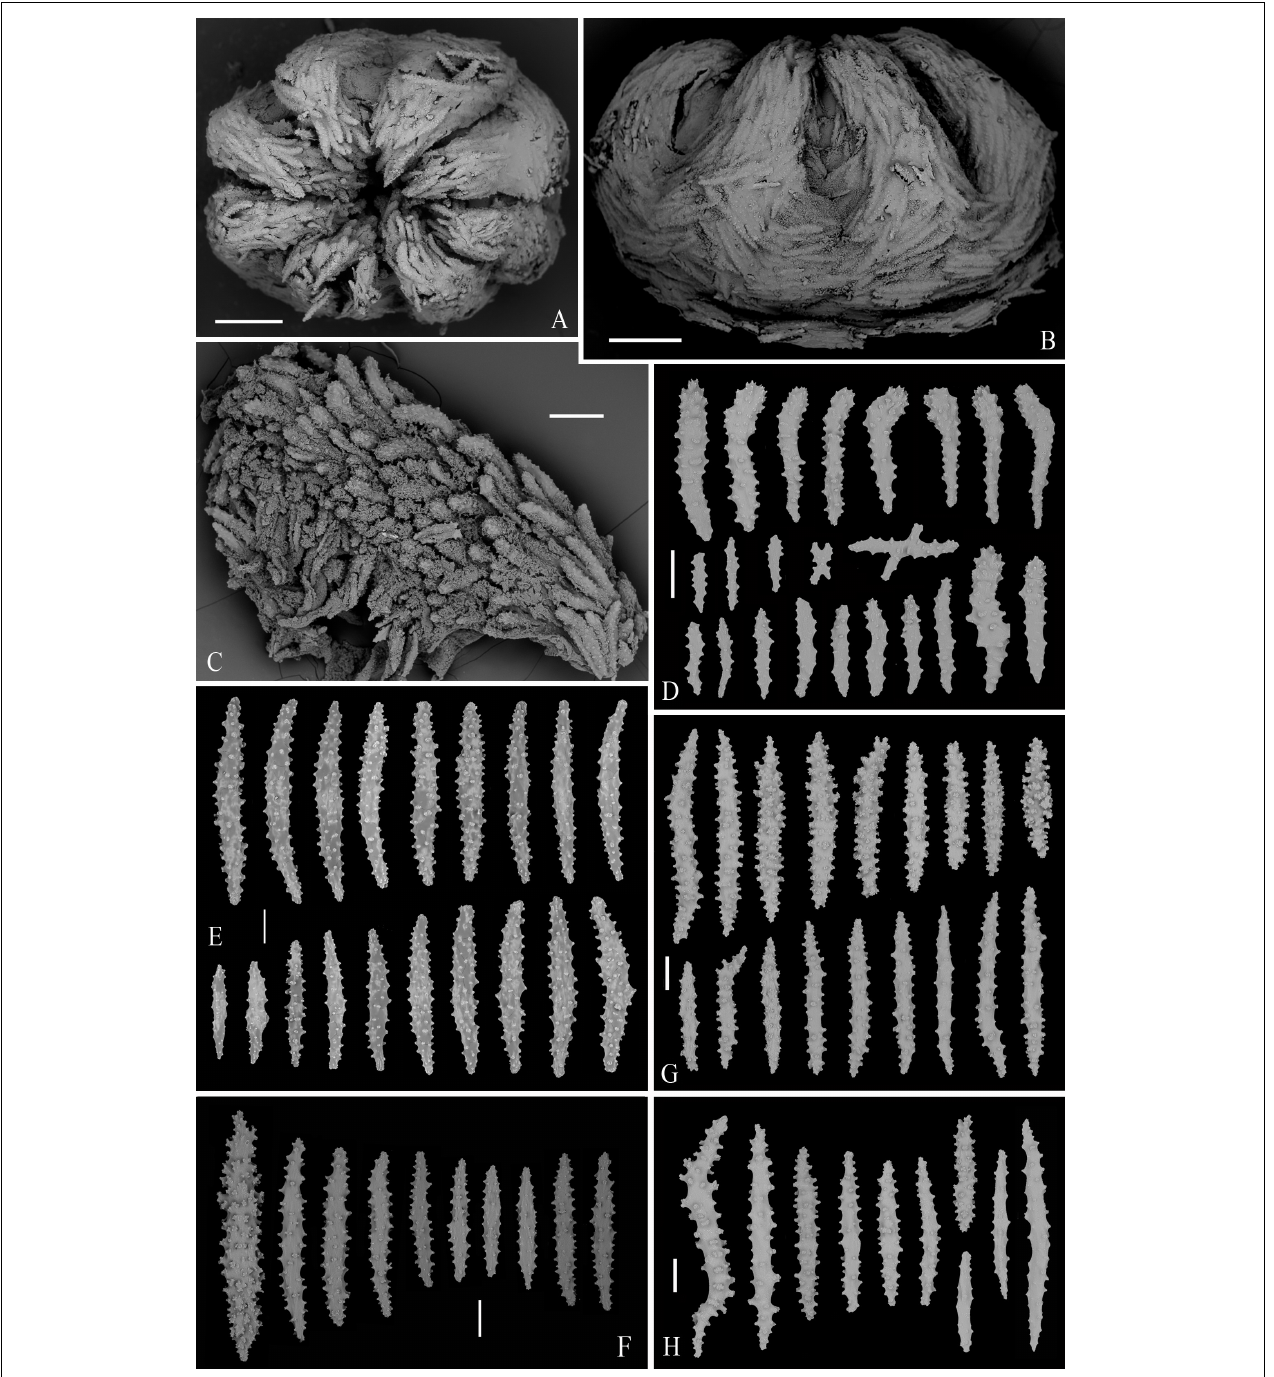
FIGURE 10 | SEM of polyps, tentacle and sclerites from the specimen MBM286394 of Victorgorgia eminens Moore et al., 2017. (A) Upper view of a polyp head. (B) Lateral view of a polyp head. (C) Part of tentacle, showing arrangement of sclerites. (D) Sclerites from tentacles. (E) Sclerites from point and collaret. (F) Sclerites from calyces. (G) Sclerites from cortex. (H) Sclerites from medulla. Scale bars = 0.5 mm (A,B) , 0.2 mm (C) , and 100 µ m (D–H)